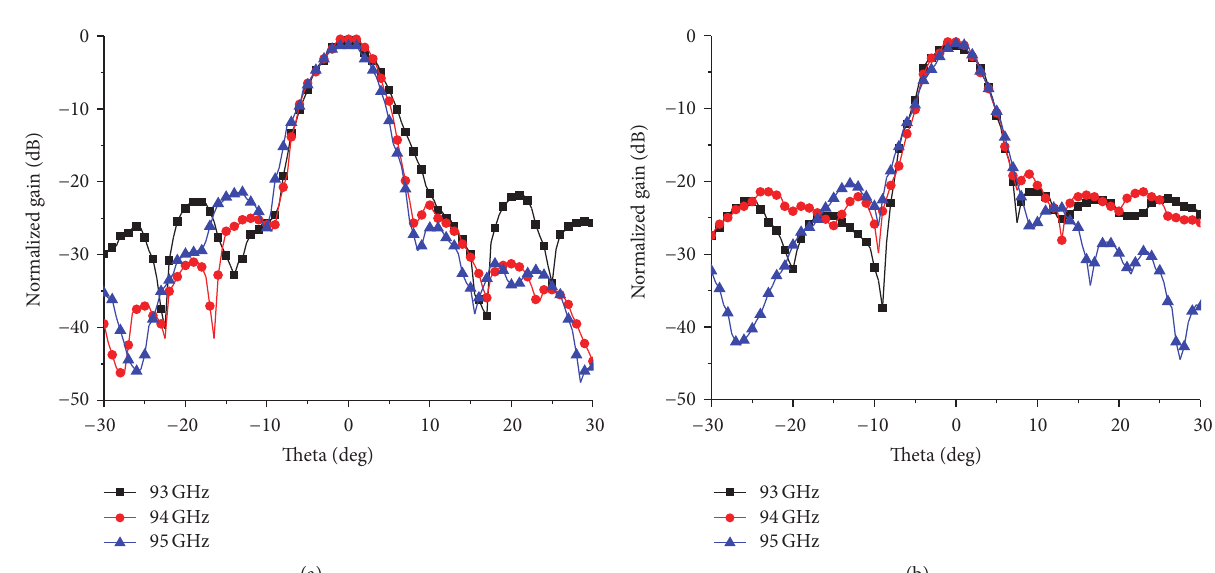
Figure 12: Measured radiation patterns at different frequencies. (a) E-plane; (b)